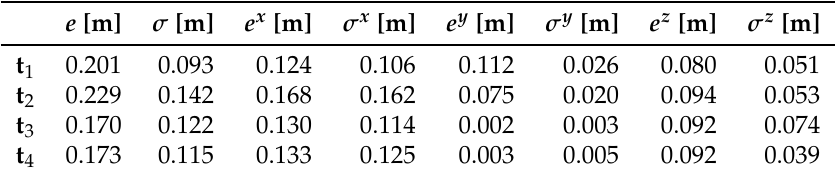
Table 3. Experimental results in Configuration 3: measured average errors ( e , e x , e y , and e z ) are shown together with the relative standard deviations ( σ , σ x , σ y , and σ z ) for the four considered positions ( t 1 , t 2 , t 3 , and t 4 ) of the